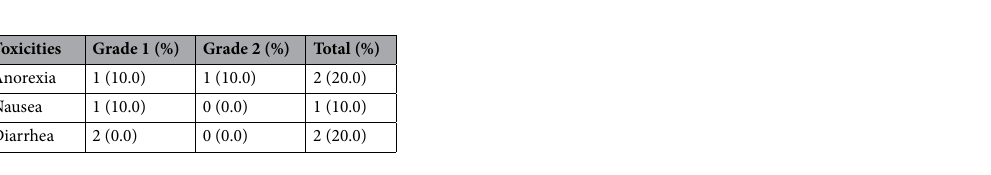
Table 5. Toxicity profiles related to radiation